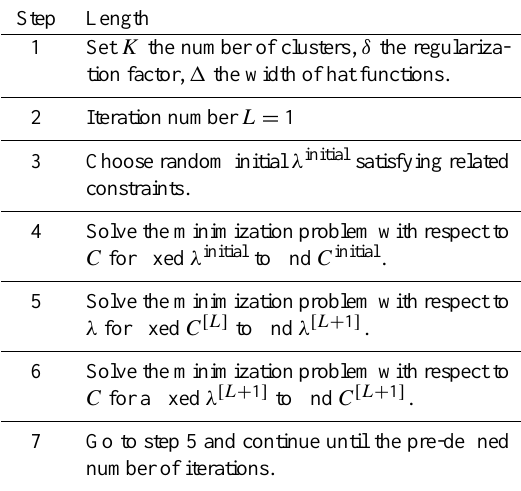
Table 1. This procedure should be followed to solve clustering op- timization and find two sets of known parameters: cluster member- ship functions and linear trend parameters in each cluster. Step Length 1 Set K the number of clusters, δ the regulariza- tion factor, 1 the width of hat